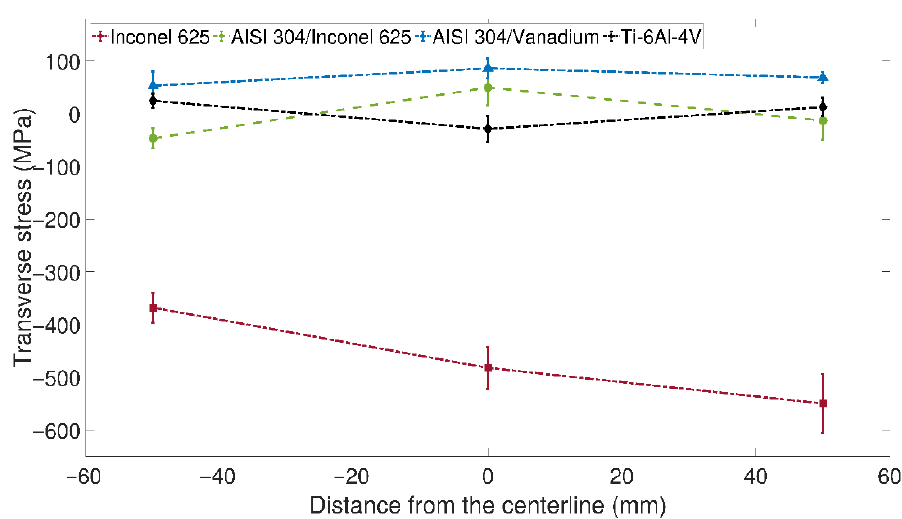
Figure 5. Surface transverse residual stresses measured by X-ray diffraction (stresses are in MPa).